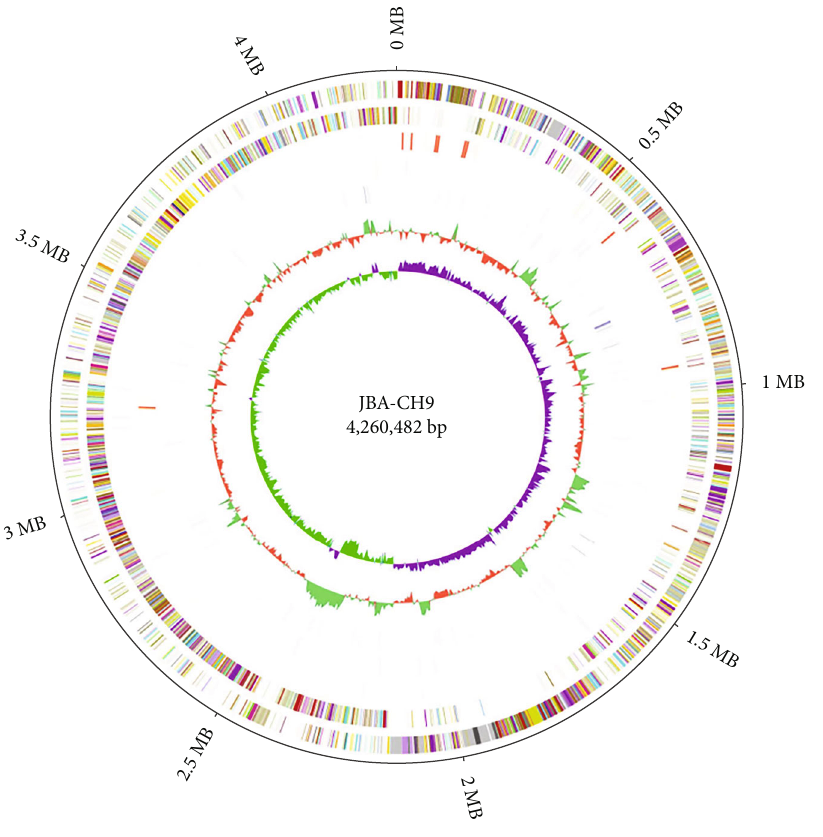
Figure 6: JBA-CH9 genome map. Table 2: Analysis of noncoding RNA components of JBA-CH9